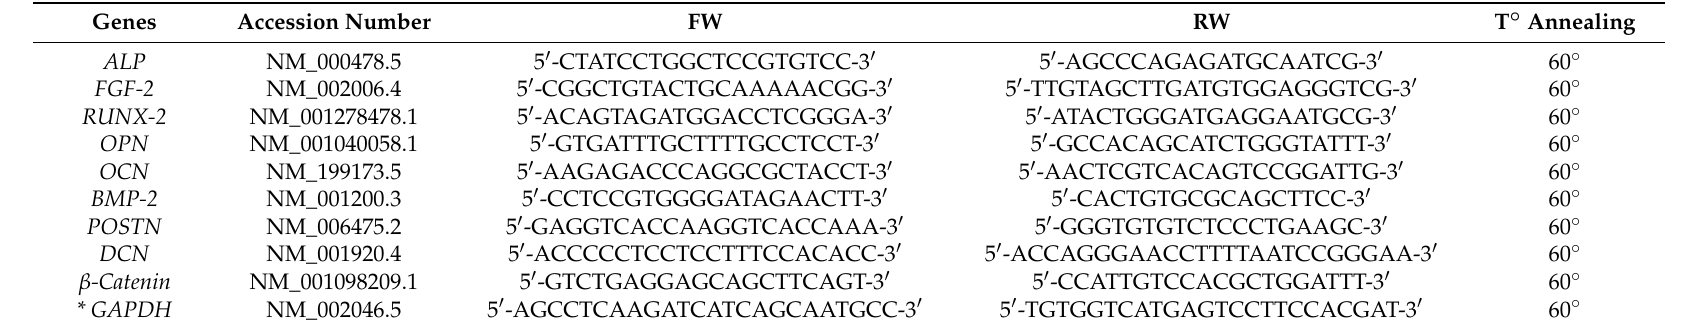
Table 1. List of the primers used for